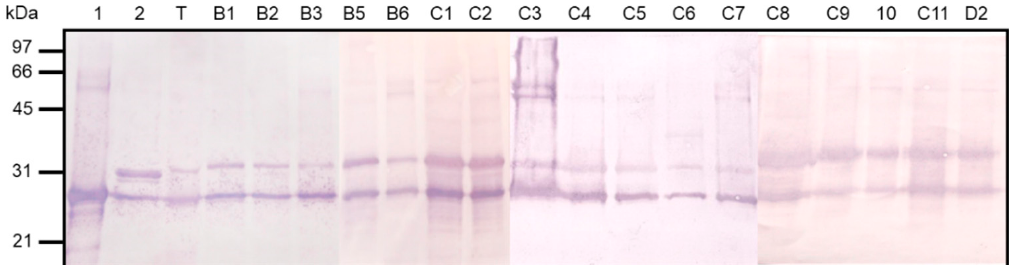
Figure 5. Conservation of the hbhA and lbp genes in human clinical isolates. PCR amplicons of the DNA coding for the N-terminal ( A ) and the C-terminal domains ( B ) of hbha A, and ( C ) of lbp obtained by using genomic DNA of M. intracellulare ATCC 13950 and lysates of 17 human isolates, as well as genomic DNA from M. avium subsp. paratuberculosis and M. avium subsp. avium indicated by 1,2 and 3, respectively. The arrows in the diagram at the top indicate the positions and directions of primers. Positions on a 100-bp ladder (Promega) ( A , C ) and a low-molecular-weight DNA ladder (New England BioLabs) ( B ), are indicated in the left margins. The sizes of the PCR products are indicated in the right margins.